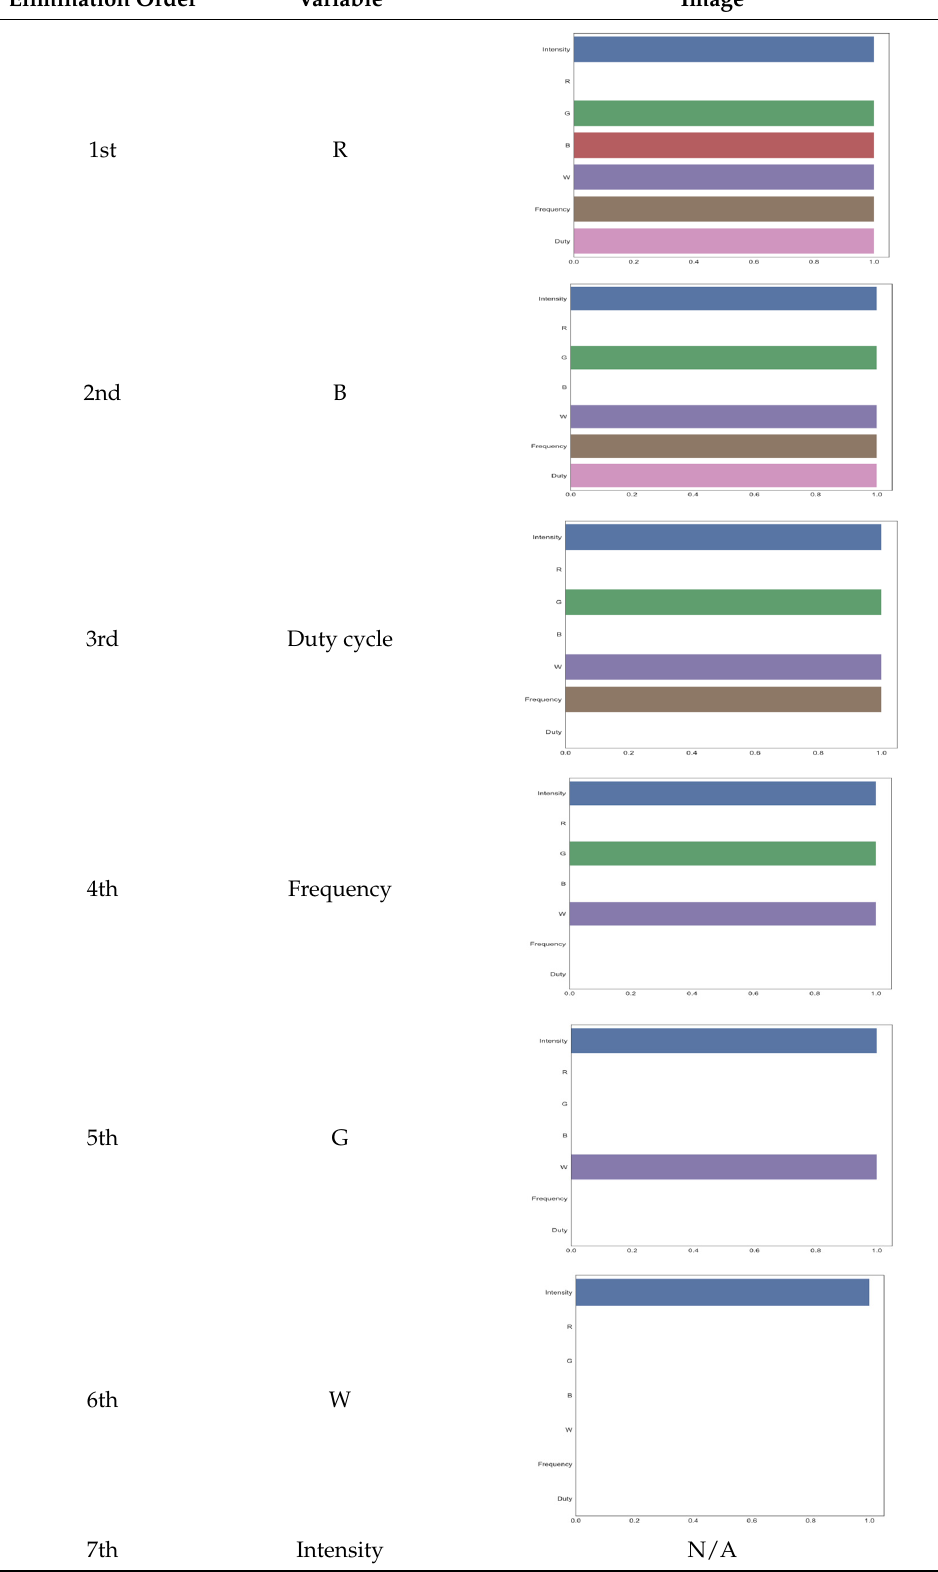
Table 8. Sequential feature selection by decision tree for depth = 2.